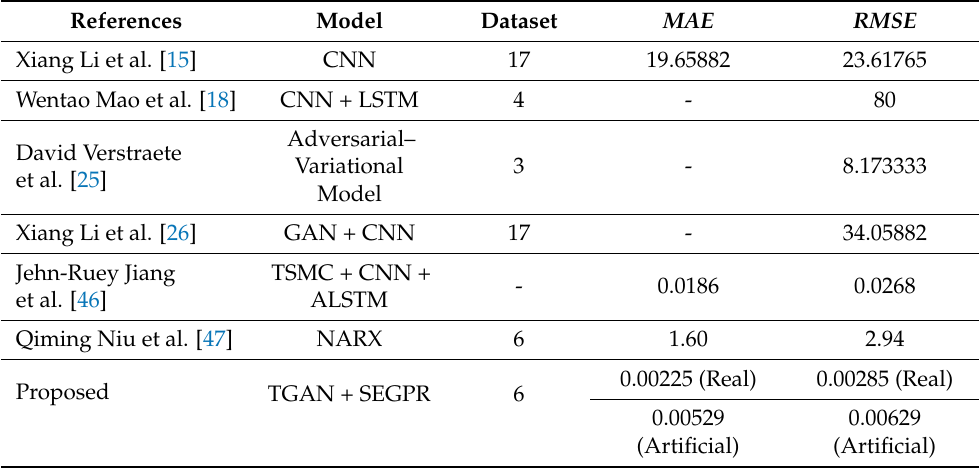
Table 4. A comparative study between current work and previously published papers to predict bearing degradation using different ML